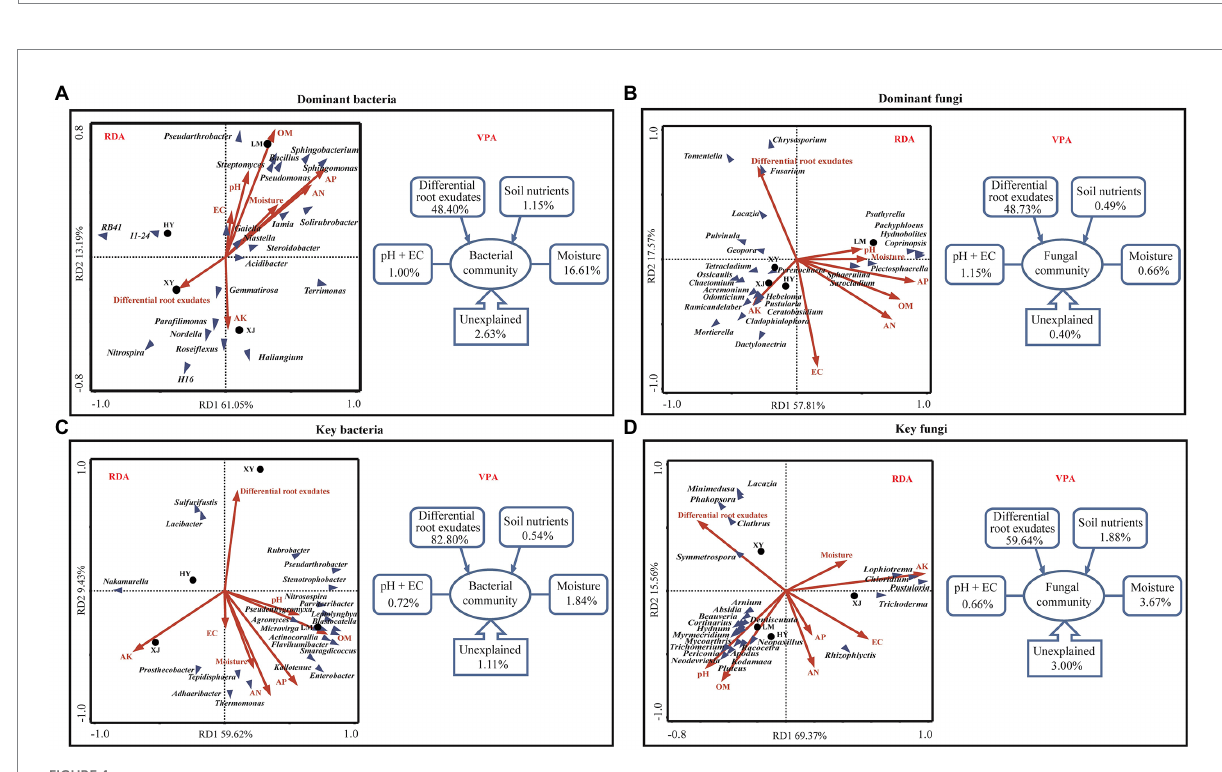
FIGURE 4 Redundancy analysis and variation partitioning analysis of microorganisms and soil properties. (A) Dominant bacteria and soil properties. (B) Dominant fungi and soil properties. (C) Key bacteria and soil properties. (D) Key fungi and soil properties. Red arrow: soil properties, blue triangle: microorganisms (In